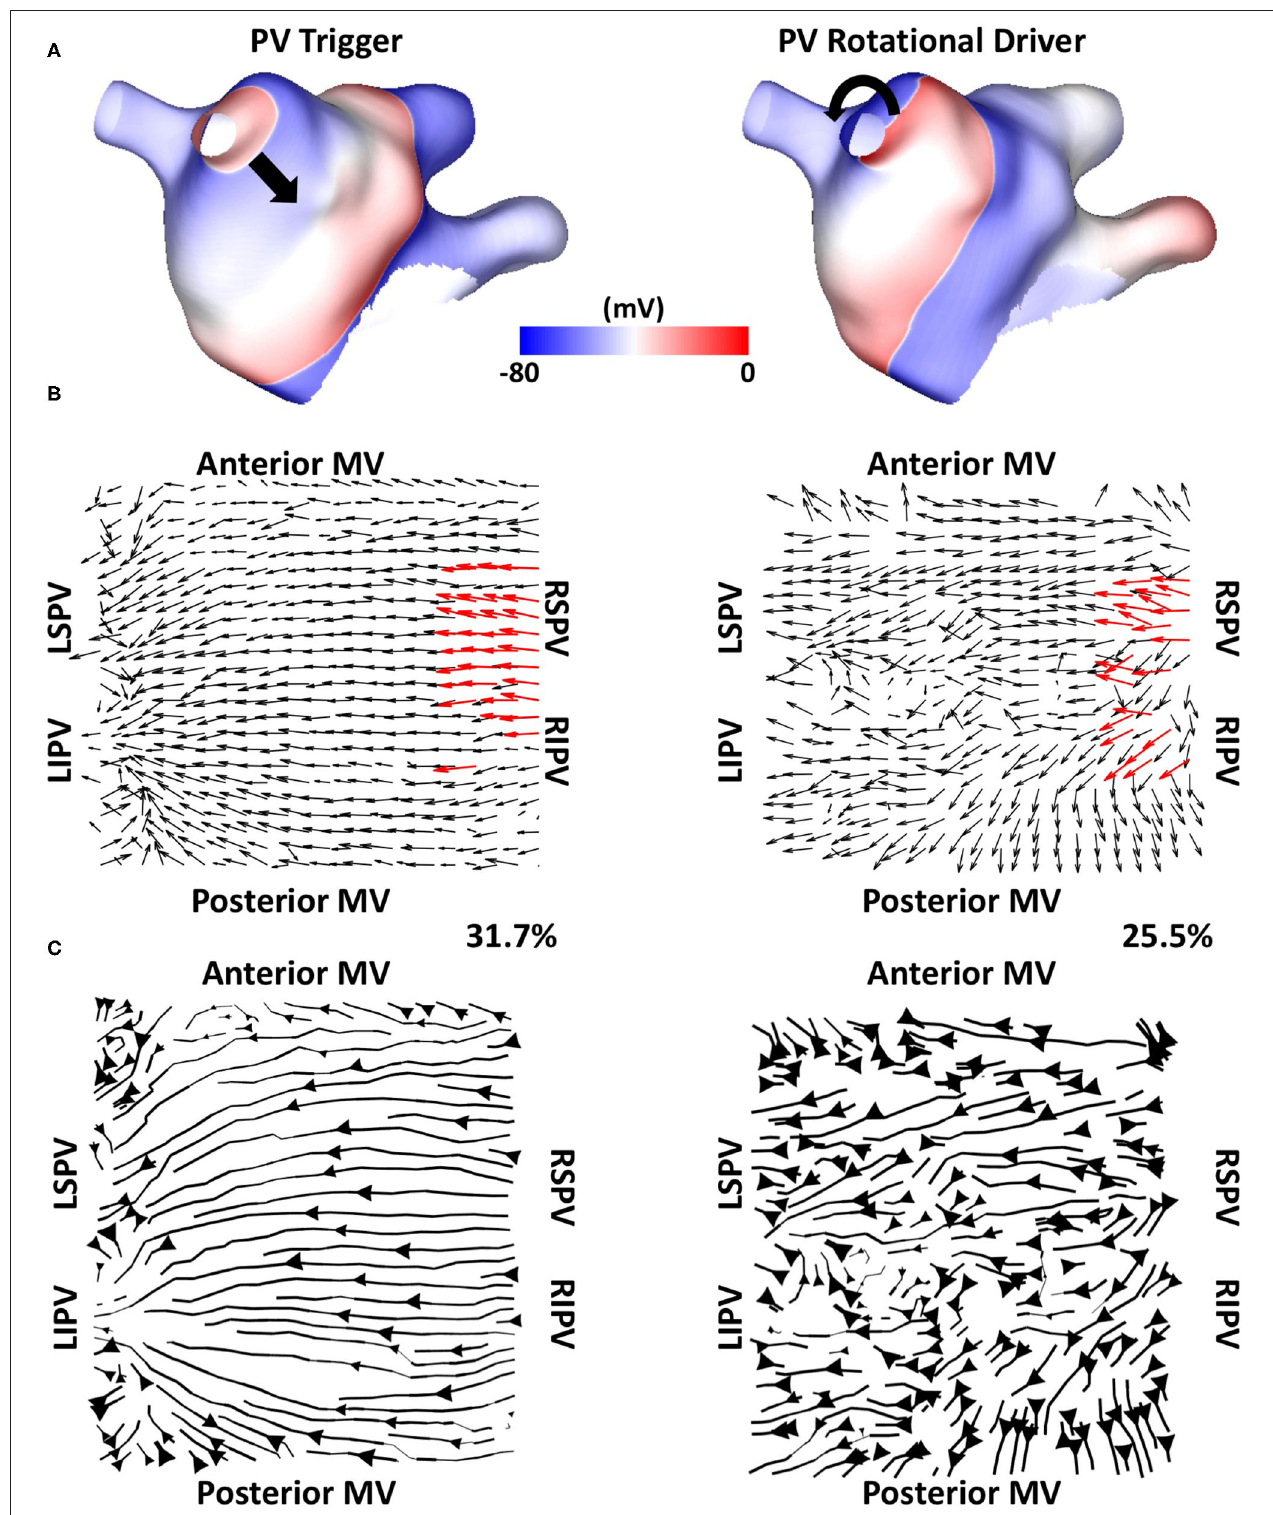
FIGURE 12 | Simulating PV triggers vs. PV rotational drivers. (A) Isopotential plots, (B) average optical flow activation vector fields and (C) activation streamlines are shown for a case sustained by PV triggers (left) and for a PV rotational driver (right).